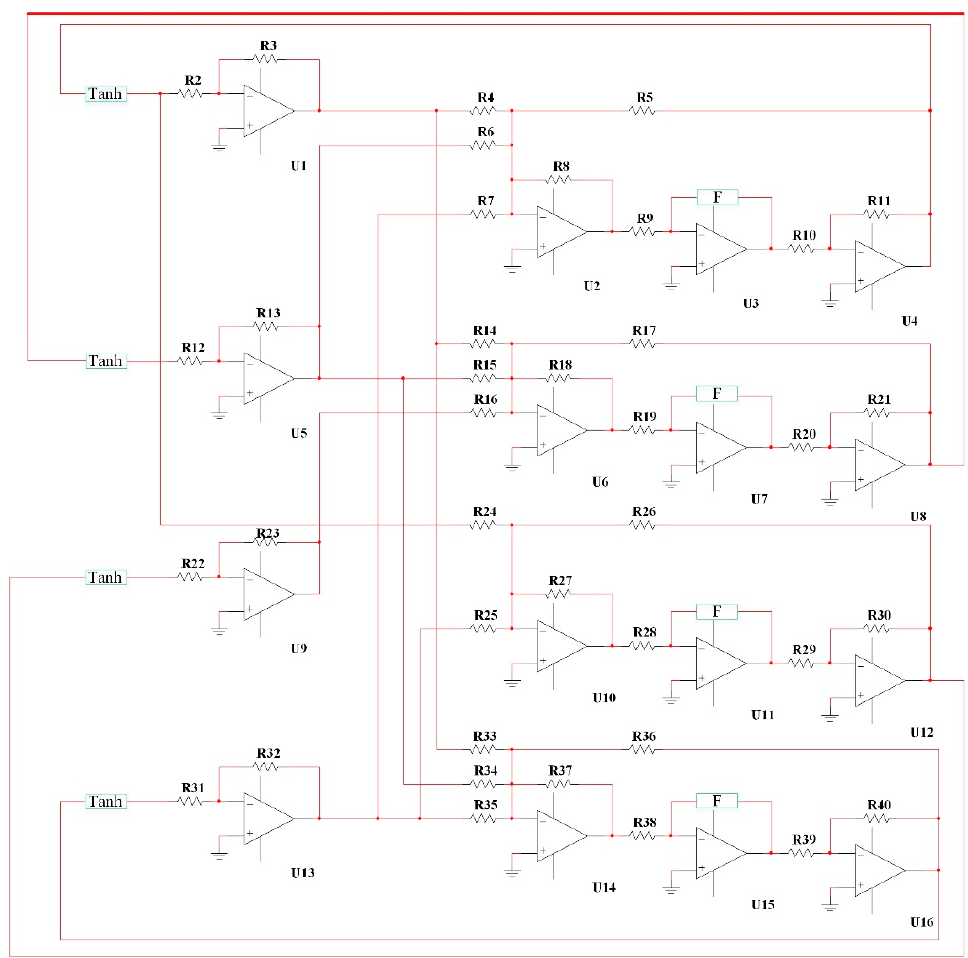
Figure 13. Realization of the circuit, based on the FOHNN system.